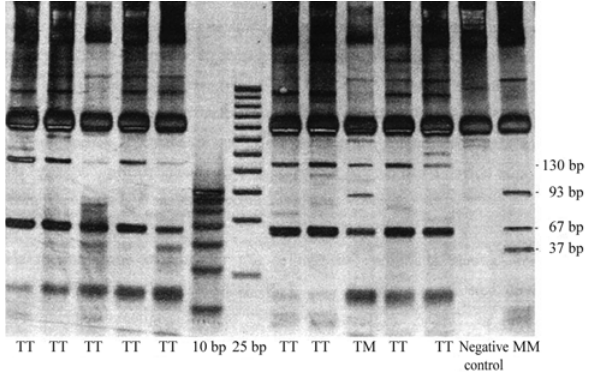
Figure 1 - Polyacrylamide gel electrophoresis showing the T945M muta- tion genotypes analyzed through the PCR/RFLP